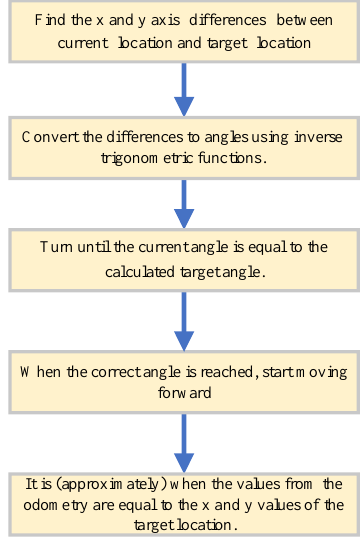
Figure 5. Flowchart of the path tracing algorithm.